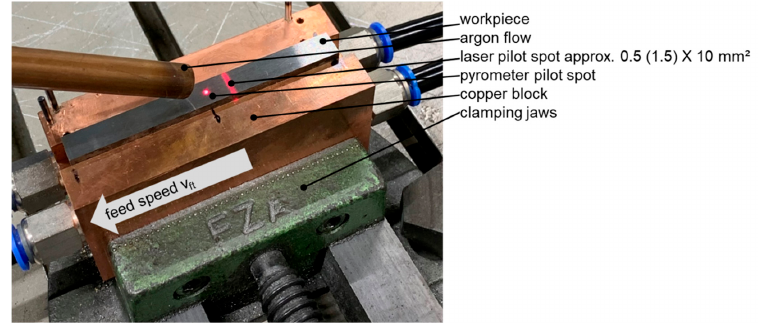
Figure 4. Setup for laser hardening of AISI 4140, with clamping.